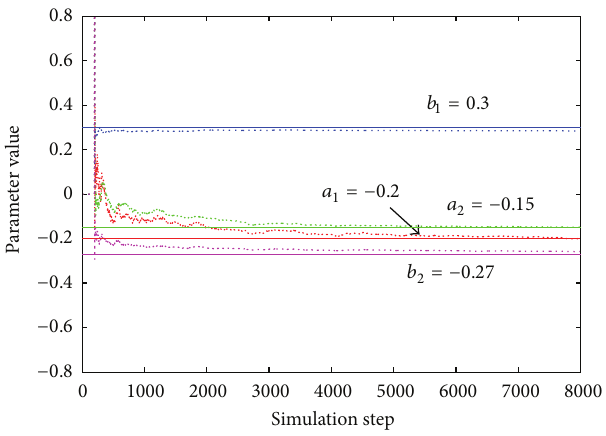
Figure 4: Estimates of System 2 by the new recursive